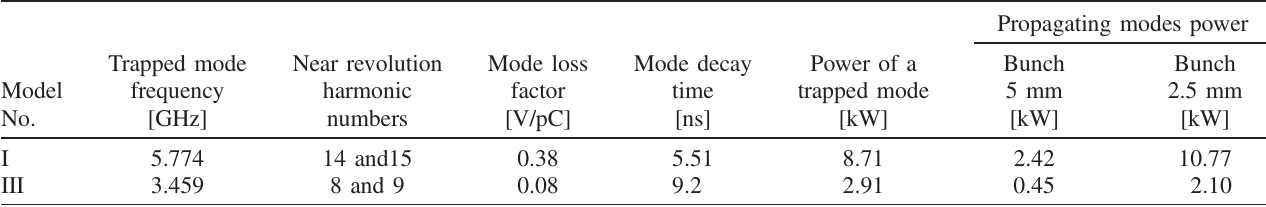
TABLE I. RF parameters of a trapped mode in the model 1 and model